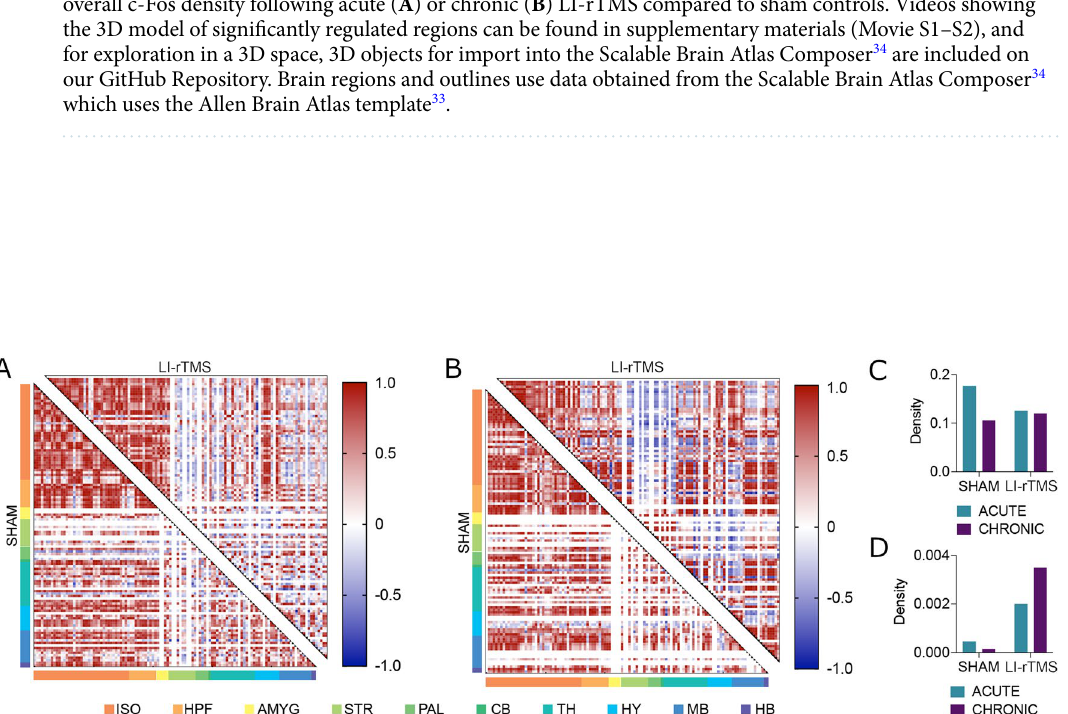
Figure 4. Brain-wide functional network topology and correlation density analyses. Functional network correlation matrices for sham (bottom left corner) and active LI-rTMS (top right corner) for acute ( A ) and chronic ( B ) stimulation groups. Matrices depict the coactivation of 115 neuroanatomical regions, with each row and column represent a single region and the intersection of rows and columns depicting the magnitude of the correlation between pairs of regions. Regions are also more broadly organised as isocortex (ISO), hippocampal formation (HPF), amygdala, (AMYG), striatum (STR), pallidum (PAL), cerebellum (CB), thalamus (TH), hypothalamus (HY), midbrain (MB), and hindbrain (HB). The prevalence of anticorrelations (depicted in blue) in the amygdala, pallidum, and striatum is increased considerably with LI-rTMS stimulation. Network density values, defined as the proportion of actual functional connections relative to the potential number of connections in a fully saturated network, show little change in ( C ) statistically significant positively correlated activity. ( D ) However, there was an increase in the density of anti-correlated activity in the network. See S1 File for list of regions in the order than they are presented in the correlation